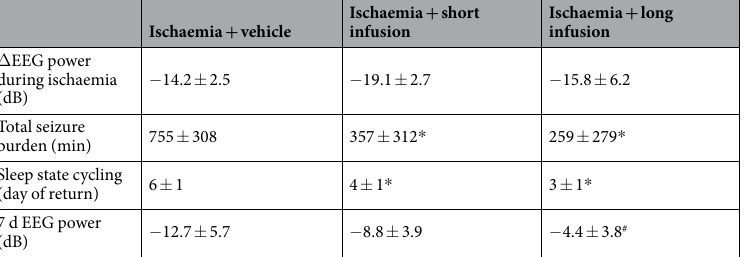
Table 1. Neurophysiological data during ischaemia and recovery in the ischaemia + vehicle, ischaemia + short infusion and ischaemia + long infusion groups. Data are mean ± SD. * P < 0.05 vs. ischaemia + vehicle, # P < 0.05 vs. ischaemia + short